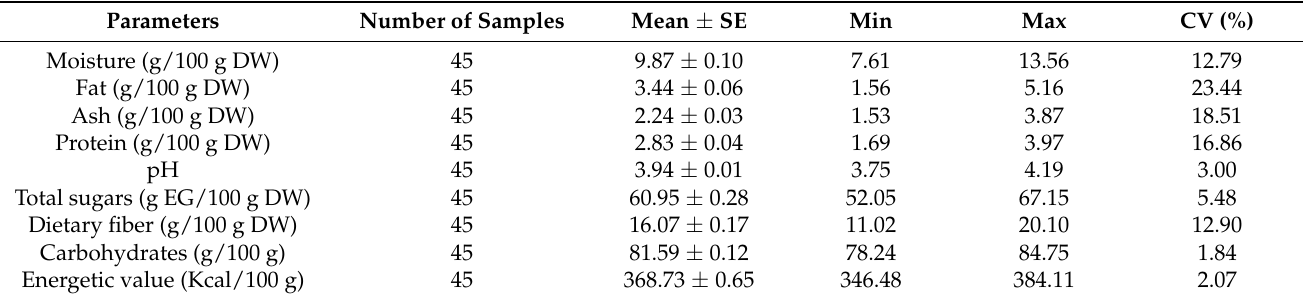
Table 2. Nutritive value average of A. unedo fruits harvested from Morocco.